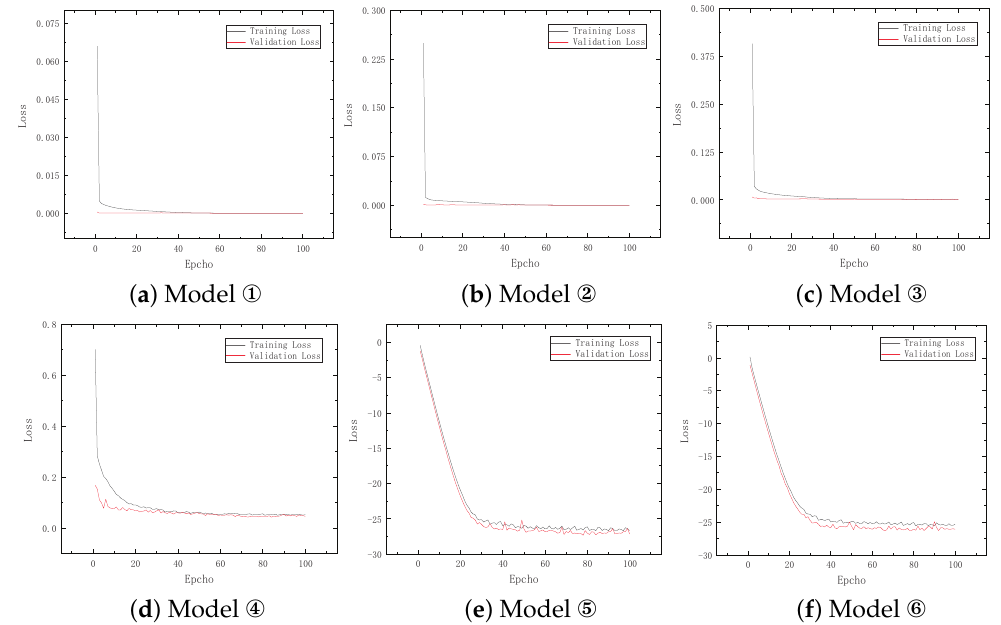
Figure 6. Variation of loss during model training. The loss of all models converges to a certain stable value, which means that all models have reached the optimal performance state under the current network